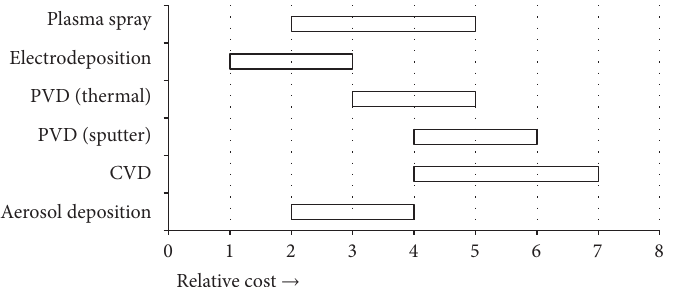
Figure 3: Graphical summary of relative cost for presented